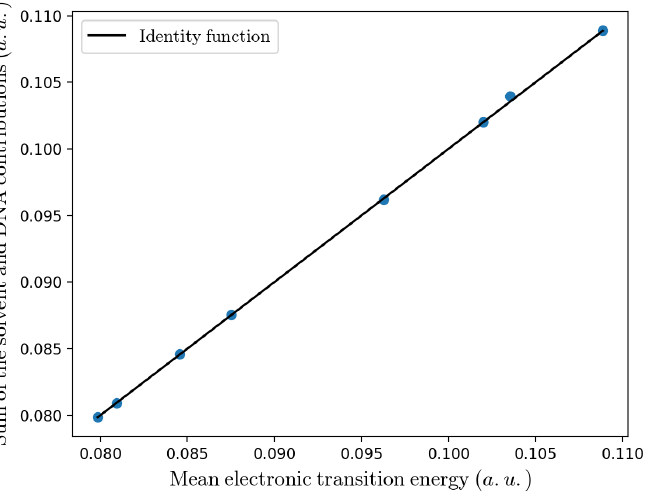
Figure 9. Comparison between the mean electronic transition energy and the sum of the solvent and DNA contributions. The solid line is the bisector of the plane. Table 3. Comparison between the calculated kinetic constant K R constant K CT for the interstrand charge transfer of the G . + substrates. In this case, the electron donor, G 3 Guanine base, is in the complementary